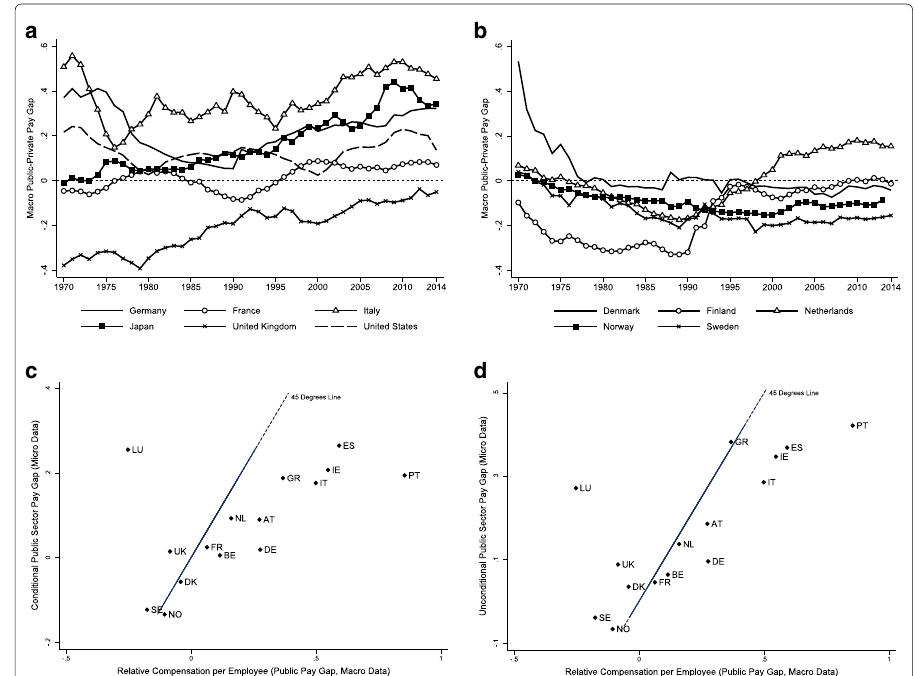
Fig. 1 Public-private pay differentials computed from macro data and comparison with micro-based pay gaps. Notes: Panels a and b show the evolution of public-private pay differentials (computed from macro data) for a selection of countries. Panel c compares the public sector pay gap conditional on observed worker characteristics (EU-SILC, see Eq. 1) with the wage gap computed from aggregate macro data (National Accounts). Panel d compares the latter with the public sector pay gap computed from micro data (EU-SILC) unconditional on observed characteristics. With the exception of Luxembourg, the cross-country patterns of micro vs. macro pay gaps are